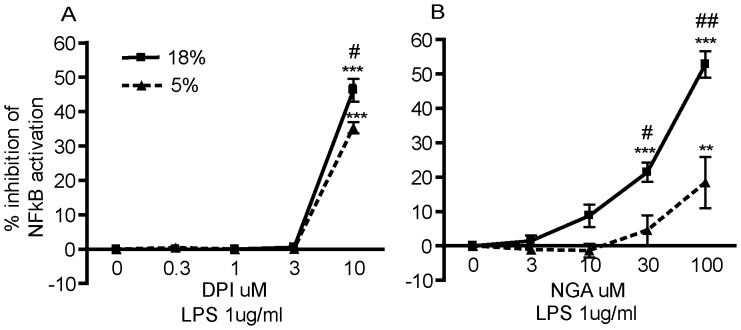
Oxygen tension influences redox in LPS-induced NF-κB activation in PMA-differentiated THP-1 cells.Undifferentiated THP-1 XBlue cells, which express an NF-κB reporter gene linked to secreted embryonic alkaline phosphatase (SEAP) were synchronized by serum deprivation for 48 h, and then differentiated with PMA (20 ng/ml) for 48 h. Differentiated THP-1 XBlue cells were then cultured in varying concentrations of DPI (A) or NGA (B) for 4 h followed by LPS (1 µg/ml) stimulation for an additional 24 h in either 18% or 5% O2. SEAP activity was quantified by QuantiBlue at 630 nm. Data are presented as the mean ± SEM (n = 2 independent experiments). *Significantly different from baseline (SEAP activity in the absence of inhibitor) at the same oxygen tension; **p<0.01; ***p<0.001 (one-way ANOVA with post hoc Tukey’s test). #Significantly different from 5% O2 at same antioxidant concentration; #
p<0.05; ##
p<0.01 (Student’s t-test).